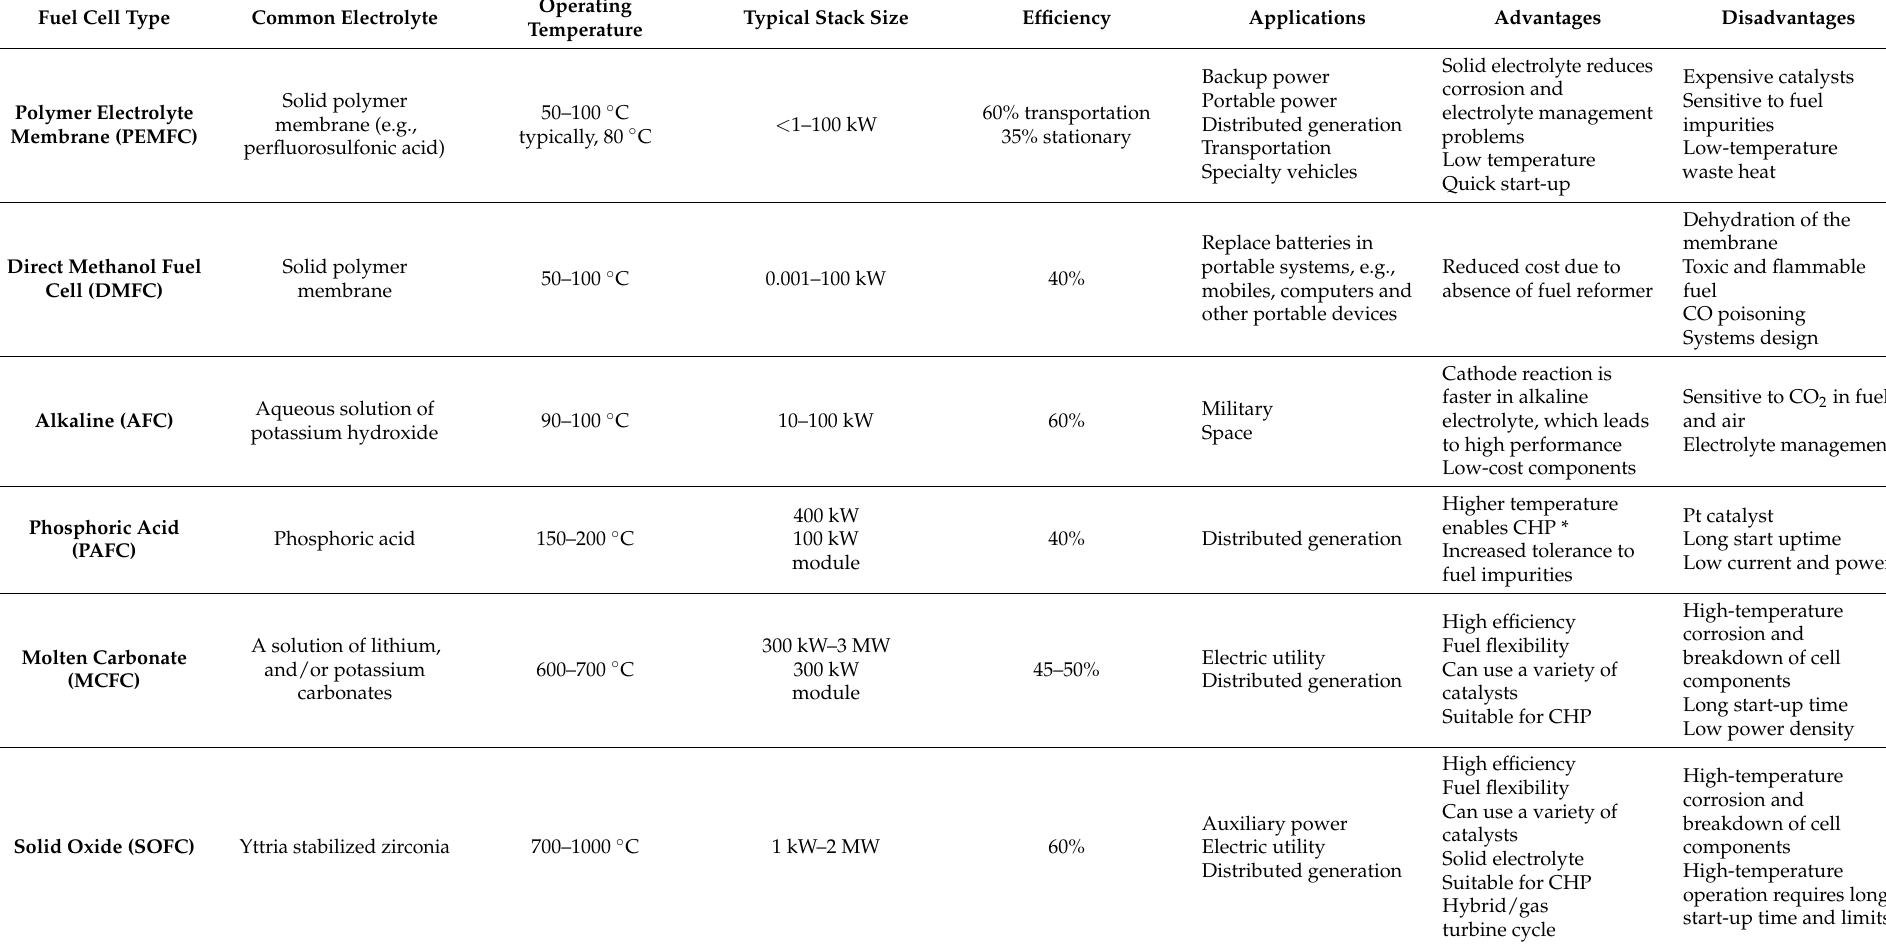
Table 3. Comparison of technical specifications of different fuel cells